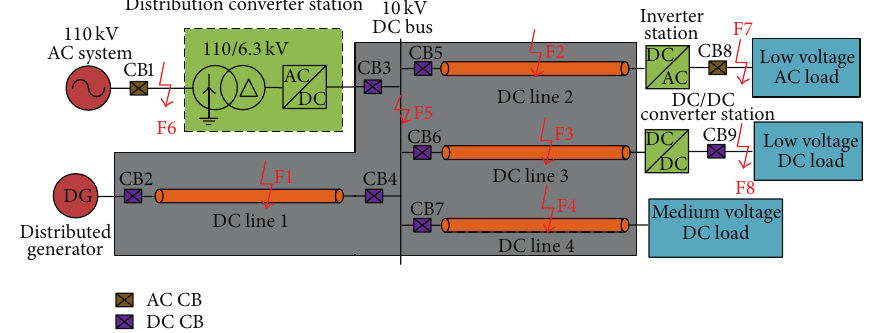
Figure 2: The diagram of simulation model of DC distribution system.